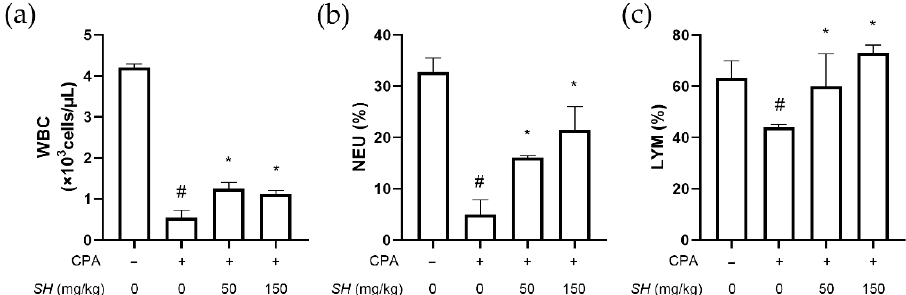
Figure 4. Effects of SH on immune cell count in a CPA-induced immunosuppressed in vivo model. SH was orally administrated in BALB/c mice for 14 days. CPA was injected on days 14 and 16 to induce immunosuppression. After sacrifice, blood was collected, and the immune cell count of ( a ) total WBC, ( b ) neutrophils (NEU) and ( c ) lymphocytes (LYM) was measured. # p < 0.05 vs. naïve mice, * p < 0.05 vs. CPA-injected mice. Results are displayed as mean ± SD of n = 10 per group. Table 2. Blood parameters in CPA-induced immunosuppressed mice.